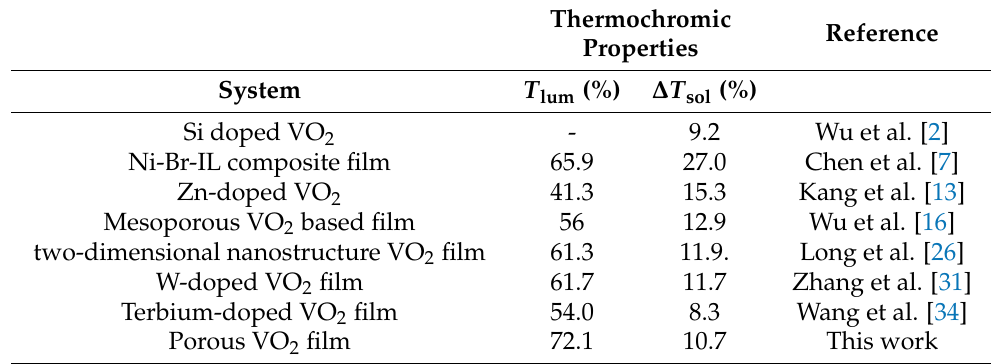
Figure 9. EDS (energy dispersive spectrometer) spectrum of ( a ) sample S1 and ( b ) sample c1 and the corresponding atomic and mass ratio for O, V and ZnO elements. Table 3. Comparison of thermochromic performance of this work with previous